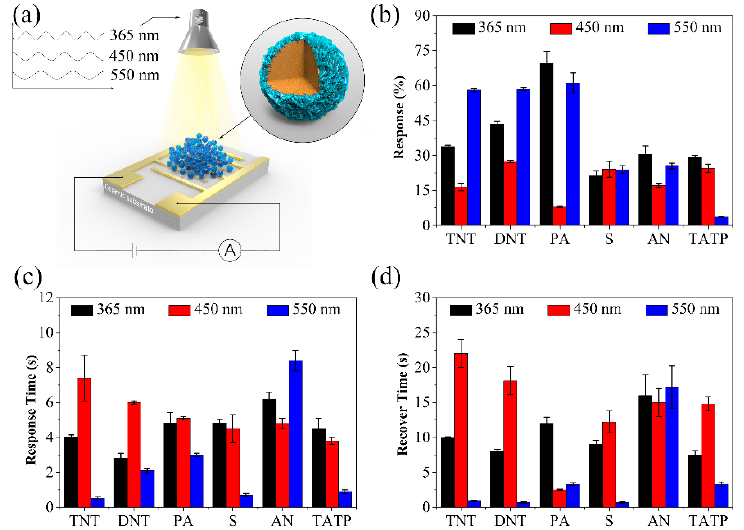
Figure 7. ( a ) Schematic diagram of sensor array realized by single TiO 2 / Aphen chip under various illumination wavelengths. Response ( b ), response time ( c ) and recover time ( d ) of TiO 2 / Aphen to different explosives under 365 nm, 450 nm and 550 nm illumination.